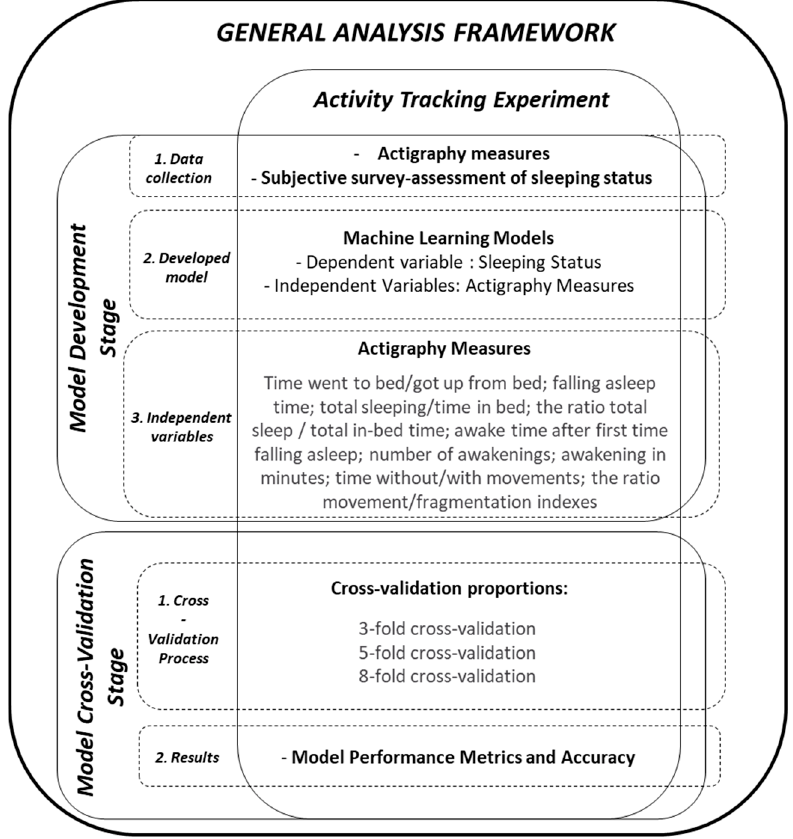
Figure 2. Model development process.